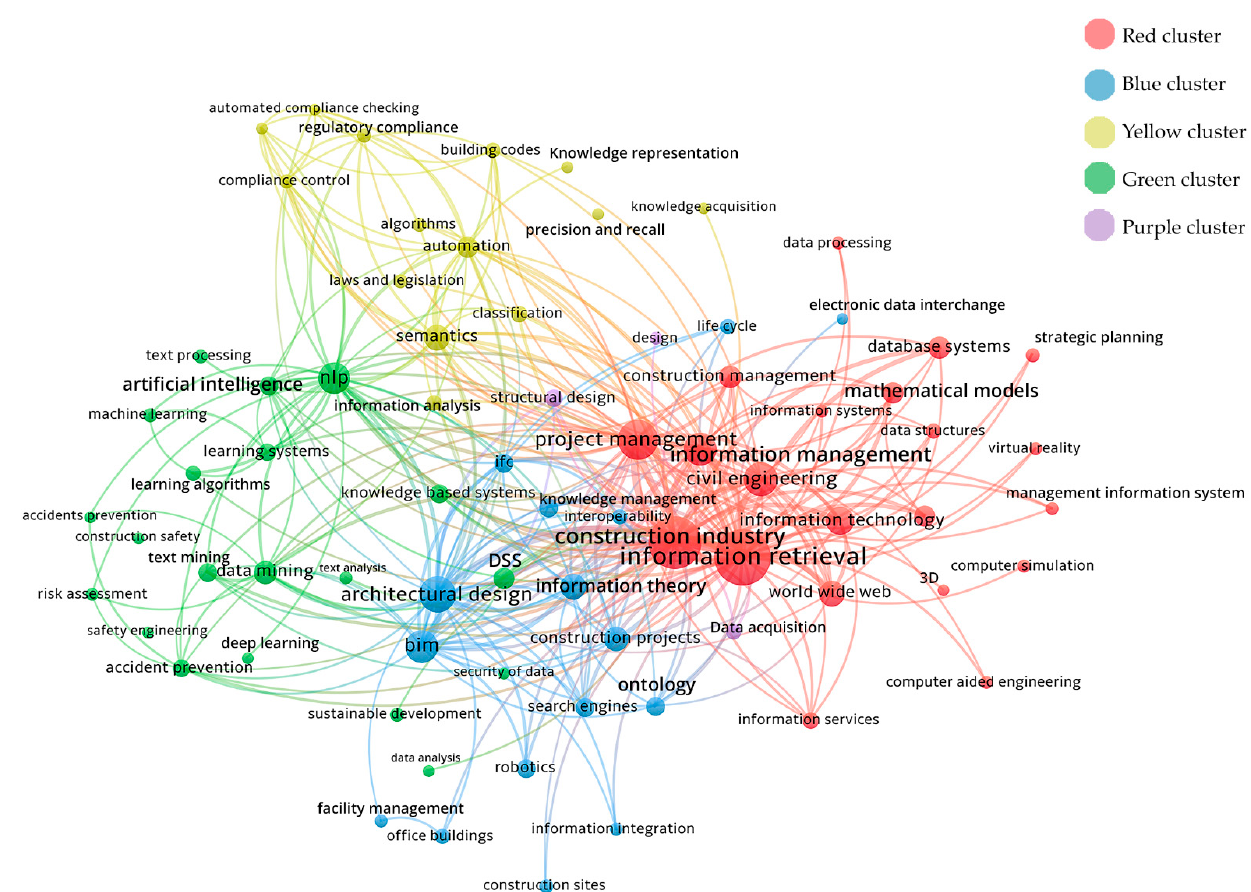
Figure 6. Co-occurrence keywords network graph. Software: VosViewer version 1.6.15.